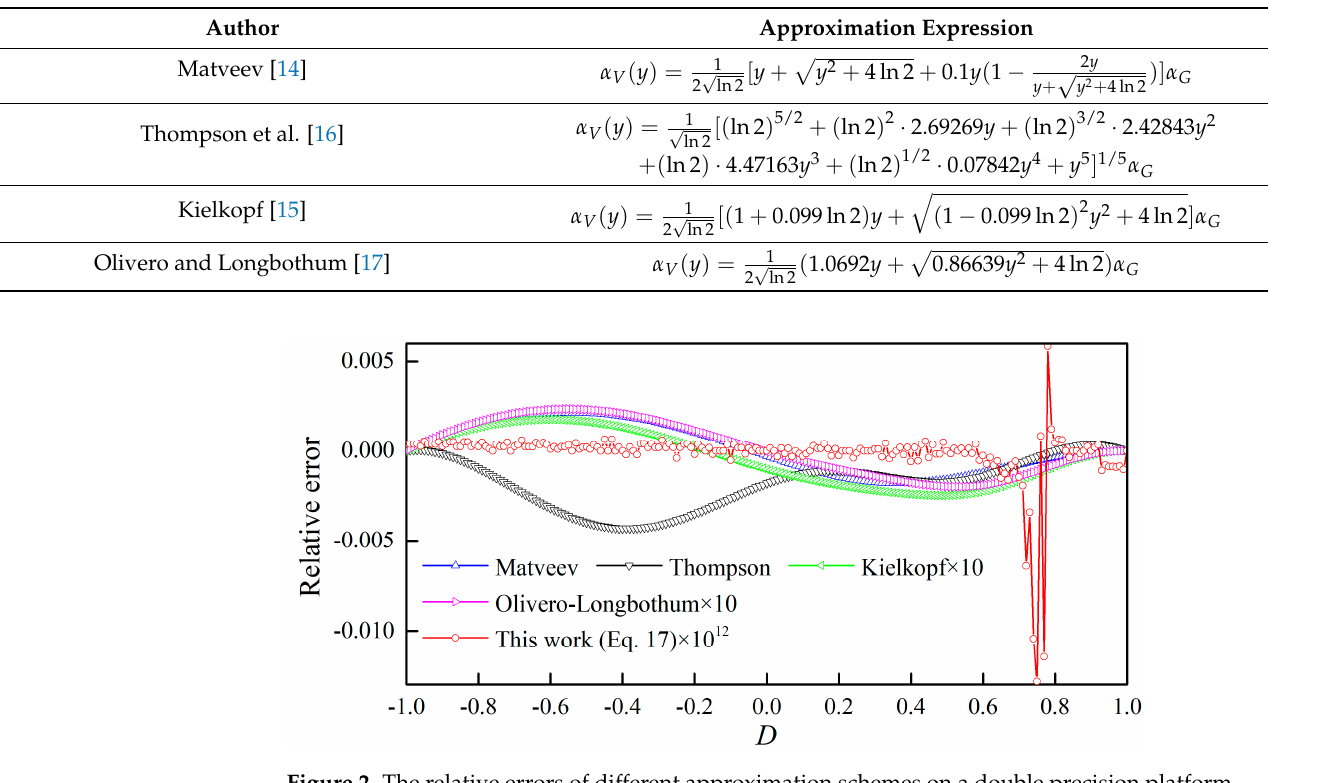
Table 1. Empirical fit to the Voigt half width.